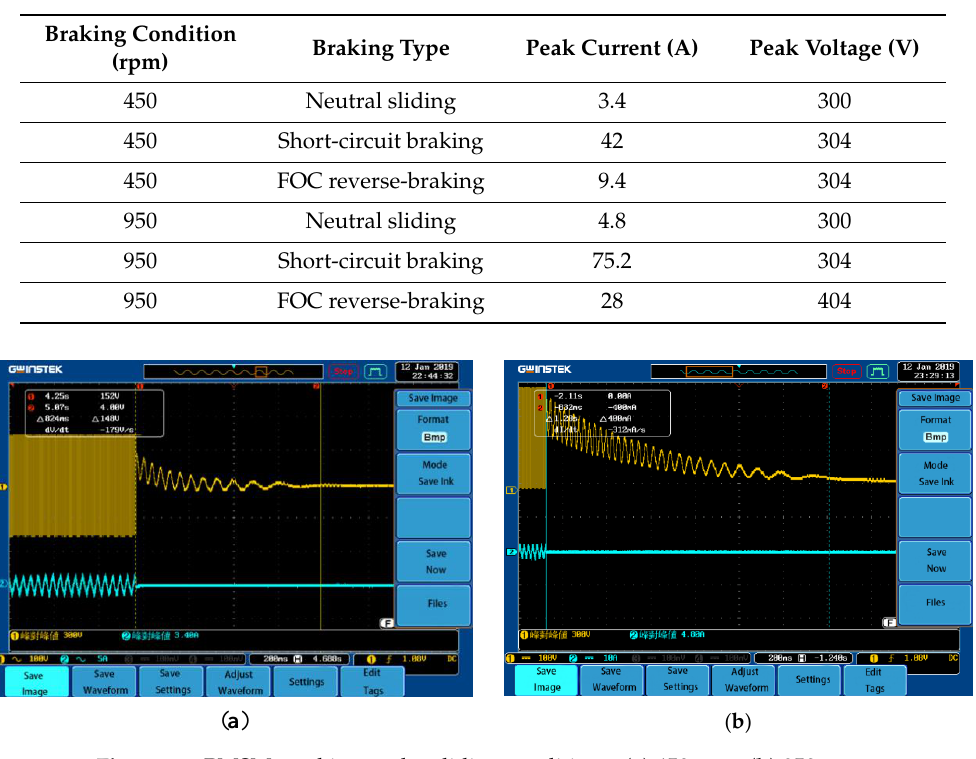
Figure 12. PMSM working under sliding conditions. ( a ) 450 rpm; ( b ) 950 rpm.